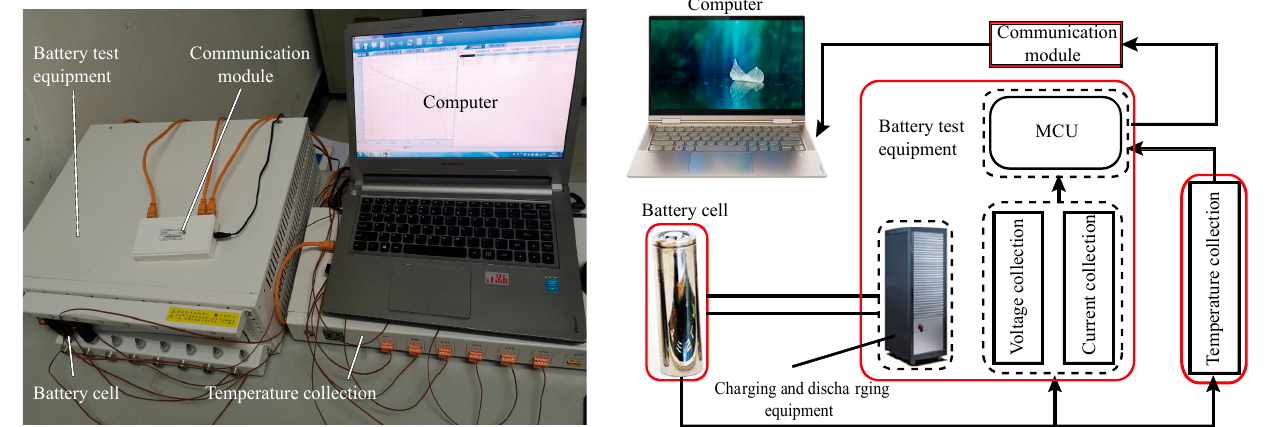
Figure 2. Ba tt ery test experiment system. Figure 2. Battery test experiment